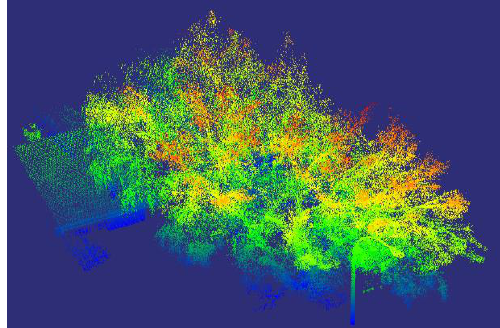
Figure 1. Street light pole with heavy vegetation interference